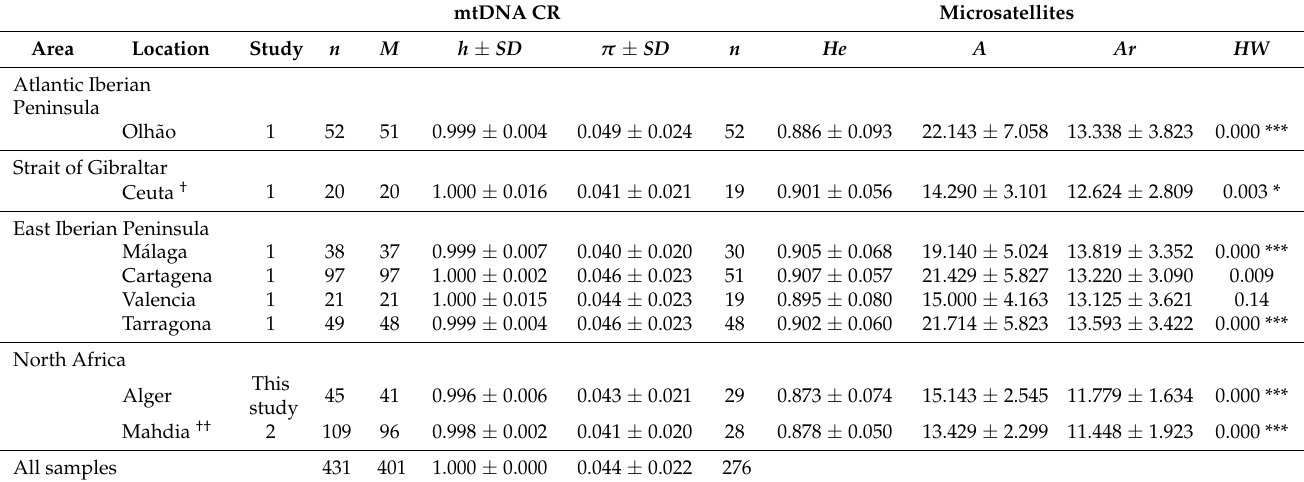
Table 1. Sampling data, capture locations, location code. For mtDNA CR, original study Oll é et al. (2019) [30] (1), Allaya et al. (2015) [29] (2), sample size ( n ), number of haplotypes ( M ), haplotype diversity and standard deviation ( h+/ − SD ), nucleotide diversity and standard deviation ( π +/ − SD ). Data for the seven microsatellites were generated in this study, sample size ( n ), expected heterozygosis and standard deviation ( He+/ − SD ), mean number alleles per locus and standard deviation ( A+/ − SD ), allelic richness and standard deviation ( Ar+/ − SD ), Hardy Weinberg equilibrium across all loci ( HW ). * Significant deviations from HW equilibrium ( p < 0.05). *** Highly significant deviations from HW equilibrium ( p < 0.001). † Ceuta is referenced in the text and legends as Strait of Gibraltar to avoid confusion with the two North African locations. †† For mtDNA CR marker individuals were collected from Ghar el Meh, Sidi Daoud and Mahdia, since no genetic heterogeneity was found between them [29], we simplified the name. For the microsatellites loci, only individuals from Mahdia amplified properly. mtDNA CR Microsatellites